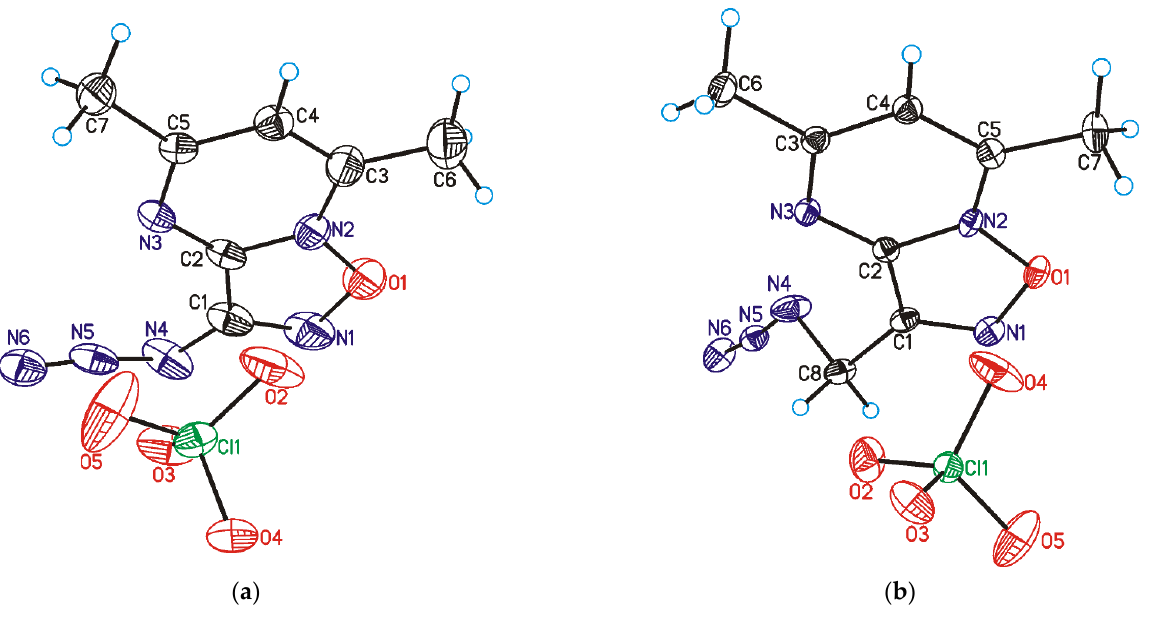
Figure 4. General view of azido compounds 10g ( a ) and 10f ( b ) showing atomic numbering. Thermal ellipsoids are given at 50% probability level. For 10g , the first symmetrically independent molecule is shown.